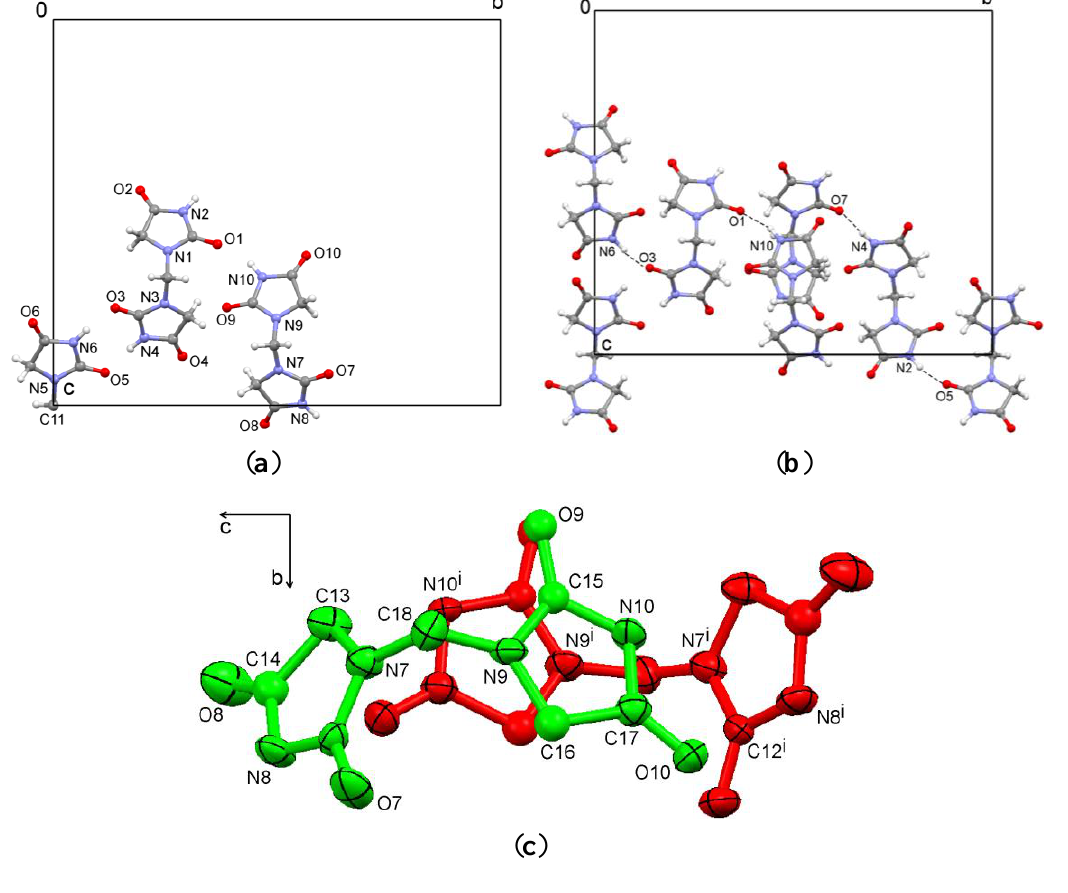
Figure 2. ( a ) Asymmetric unit; ( b ) Hydrogen bonding of 1,1′-methylenebis(imidazolidine- 2,4-dione) ( 1 ); ( c ) View of the disordered molecule; symmetry operation (i): − x , y ,3/2 − z ; hydrogen atoms omitted for clarity.